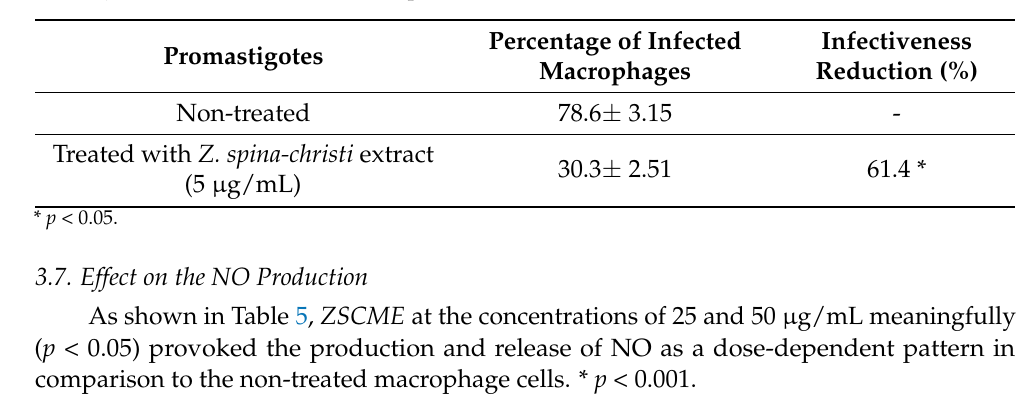
Table 4. Inhibition of the infection in macrophage cells after treatment of L. major promastigotes with the Z. spina-christi extract. Data are expressed as the mean ± SD ( n = 3).